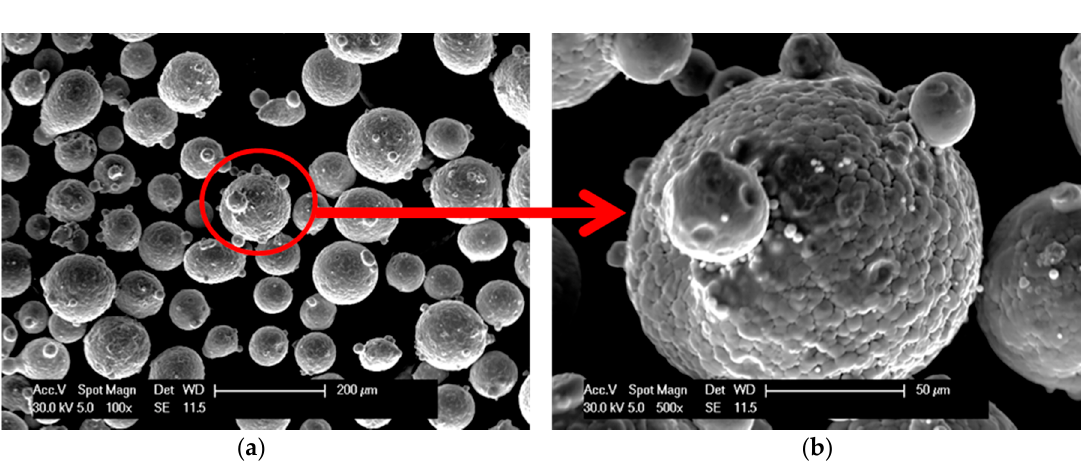
Figure 2. The morphology of Fe 3 Al powder particles at low ( a ) and high magnification ( b ).